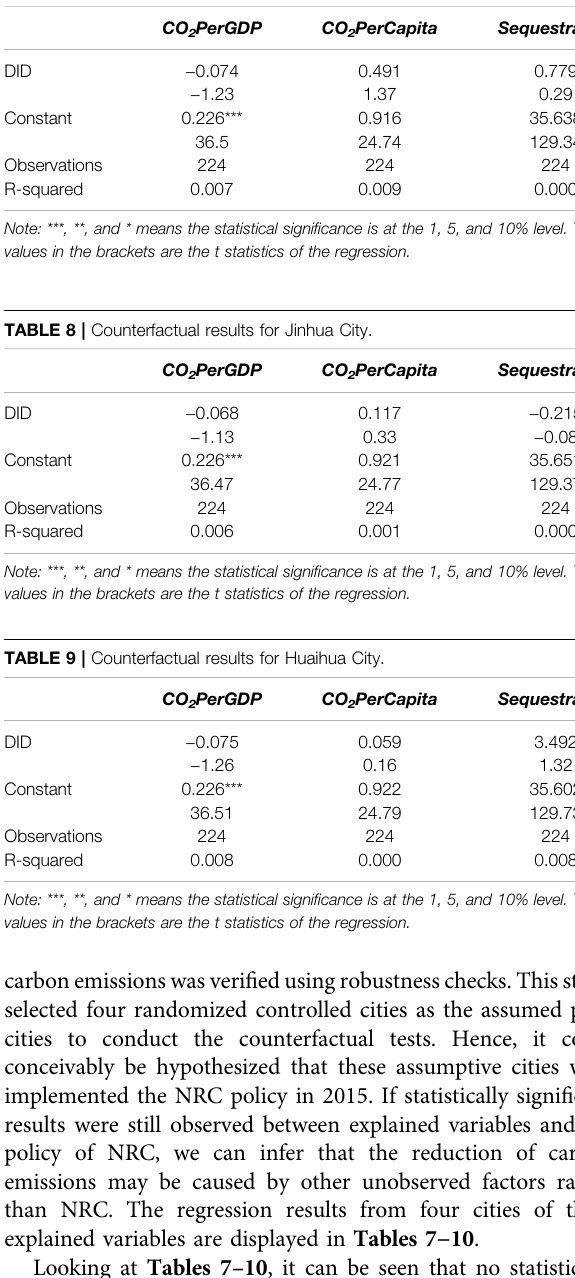
TABLE 10 | Counterfactual results for Baoji City.